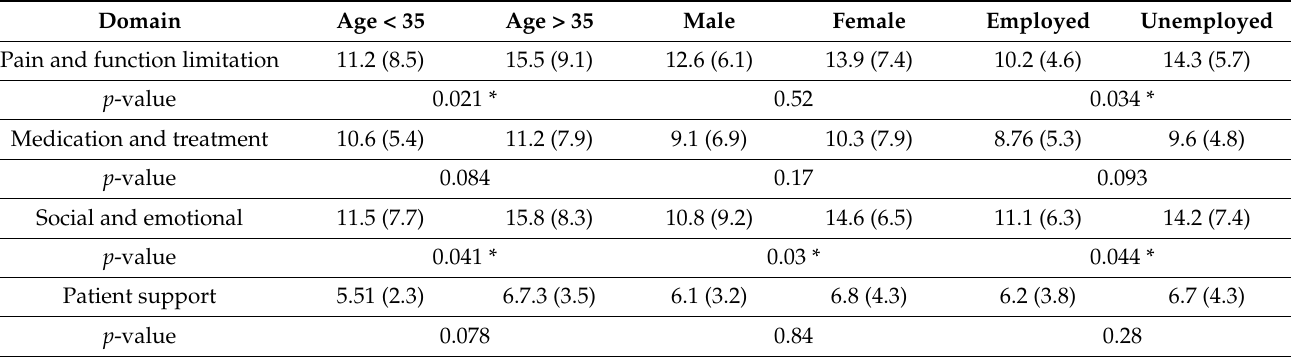
Table 4. The summary of the relationship of socio-demographic characteristics with domains of